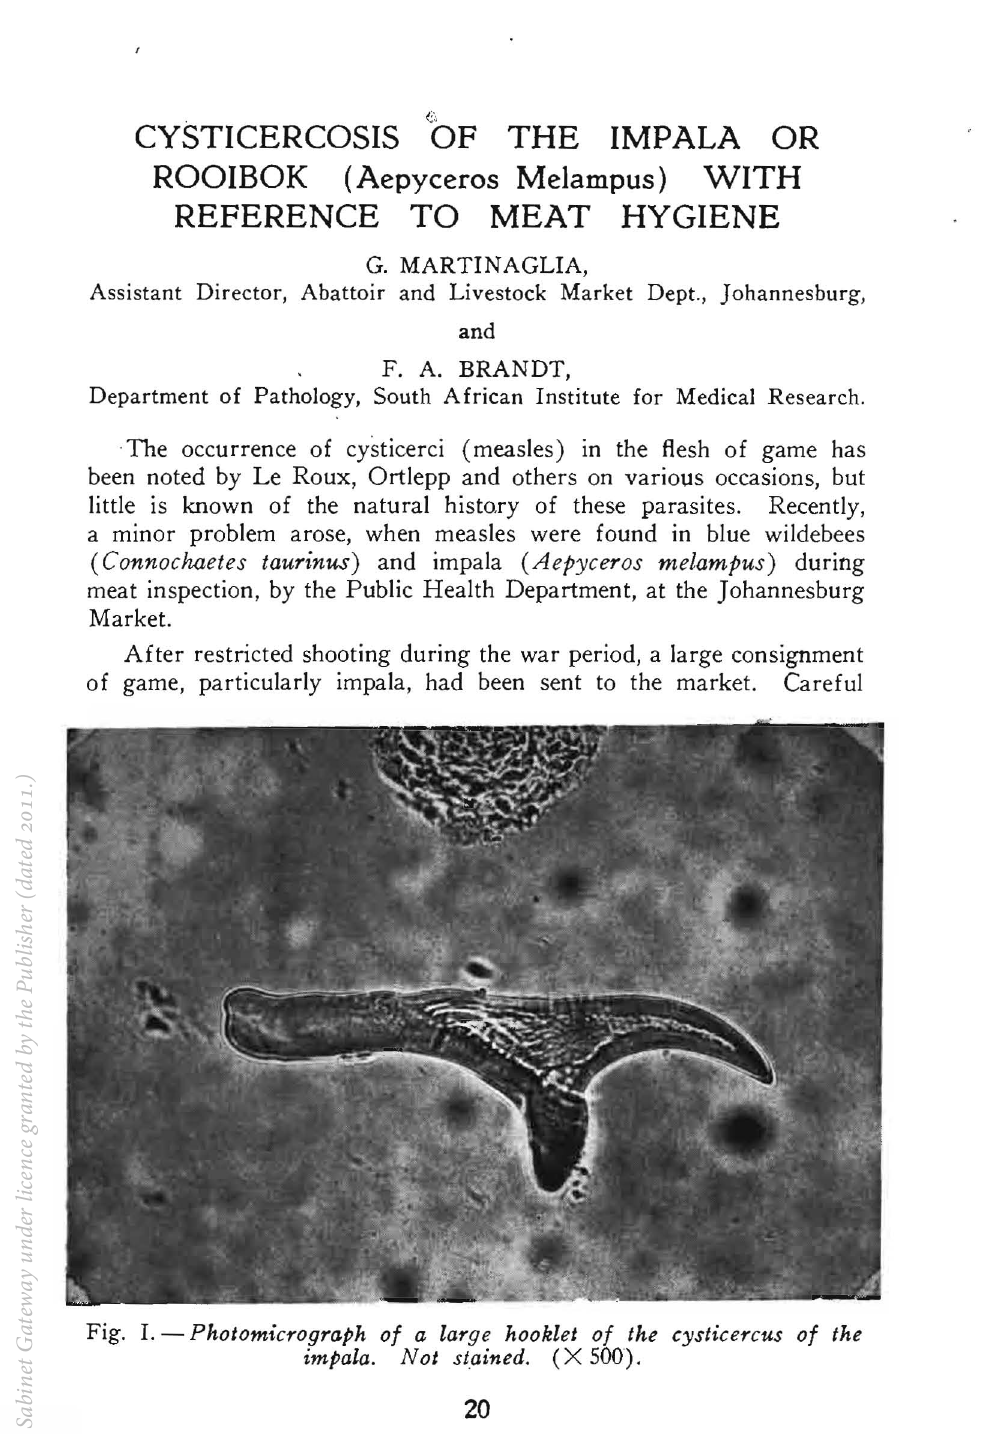
Fig. I. - Photomicrograph of a large hooklet of the cysticercus of the impala. Not stained. (X 500).